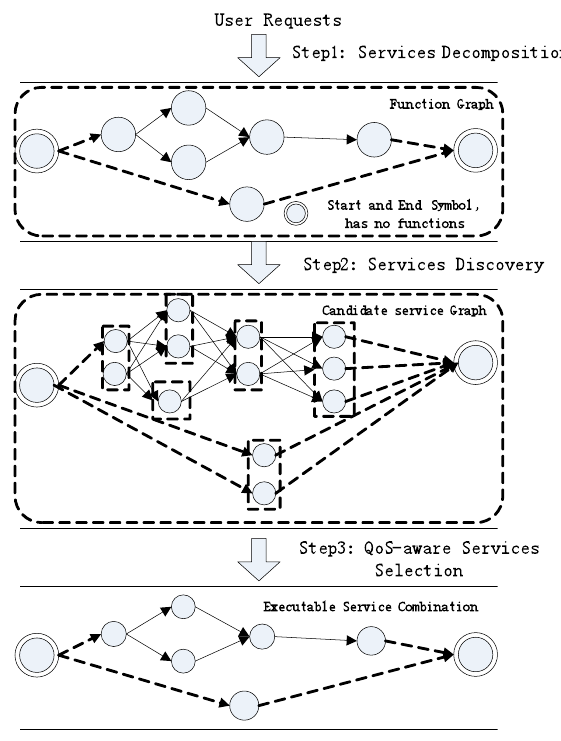
Fig. 3 Procedure on QoS-aware Web service